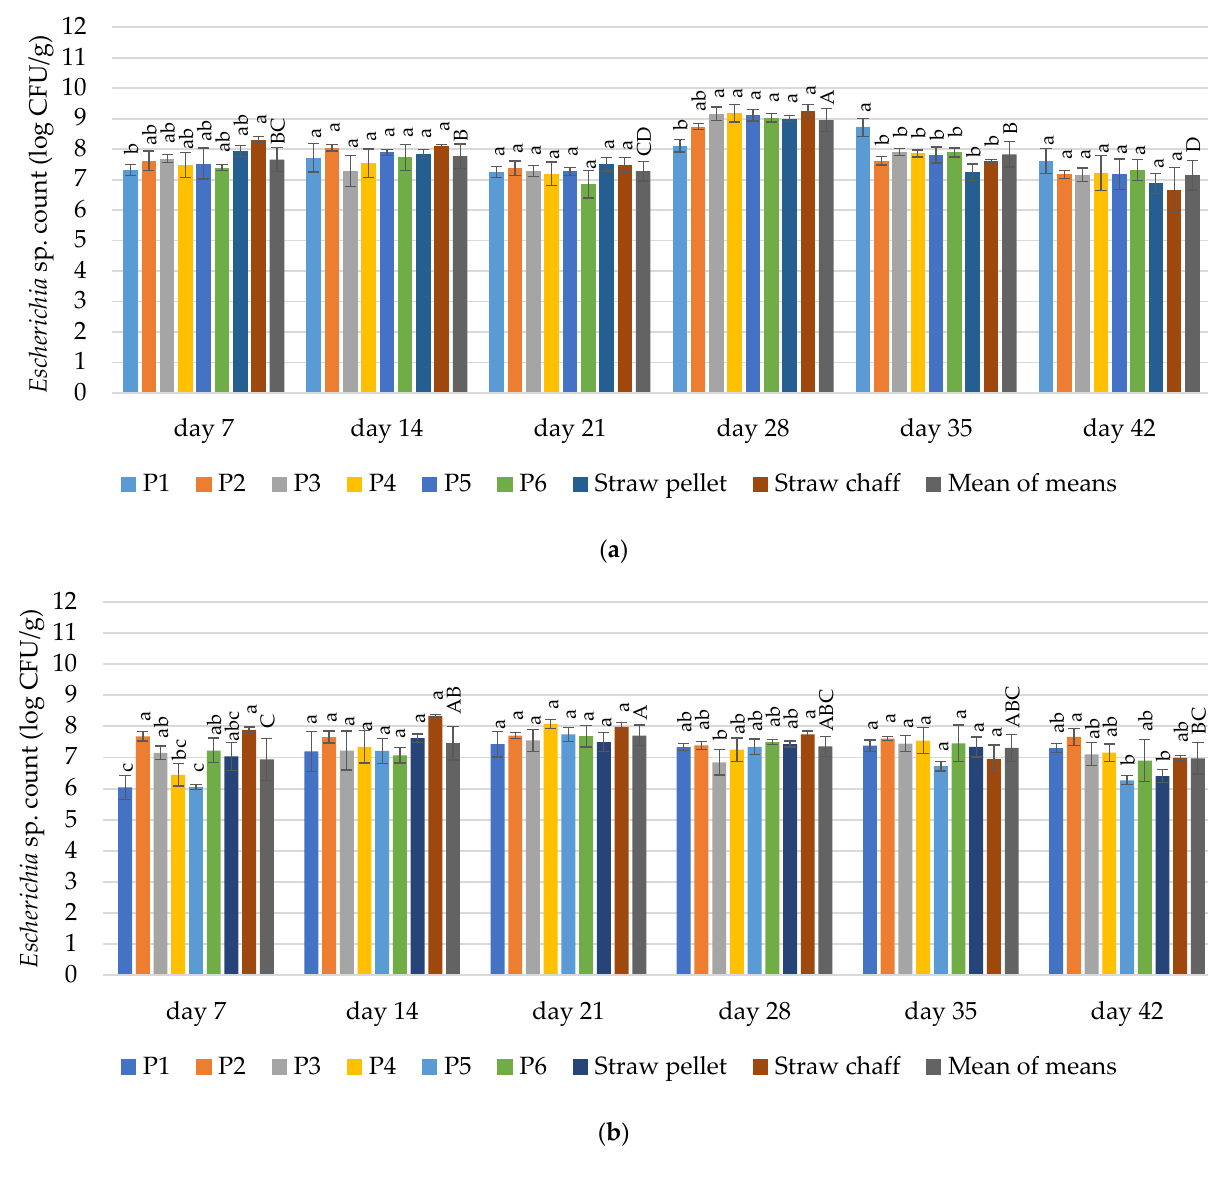
Figure 5. Changes in the count of microorganisms of Escherichia sp. in the tested bedding materials: ( a ) 1st experimental cycle; ( b ) 2nd experimental cycle. All values are means of three independent replicates ± SD, except the last bars for each day, which are the means-of-means. For each day, means with a common lowercase letter are not significantly different by the Tukey test at the 5% level of significance. For different days, means-of-means with a common uppercase letter are not significantly different by the Tukey test at the 5% level of significance. Pairwise comparisons between materials are presented only for observations from the same day. Pairwise comparisons between days are presented only for means-of-means. No pairwise comparisons between cycles are